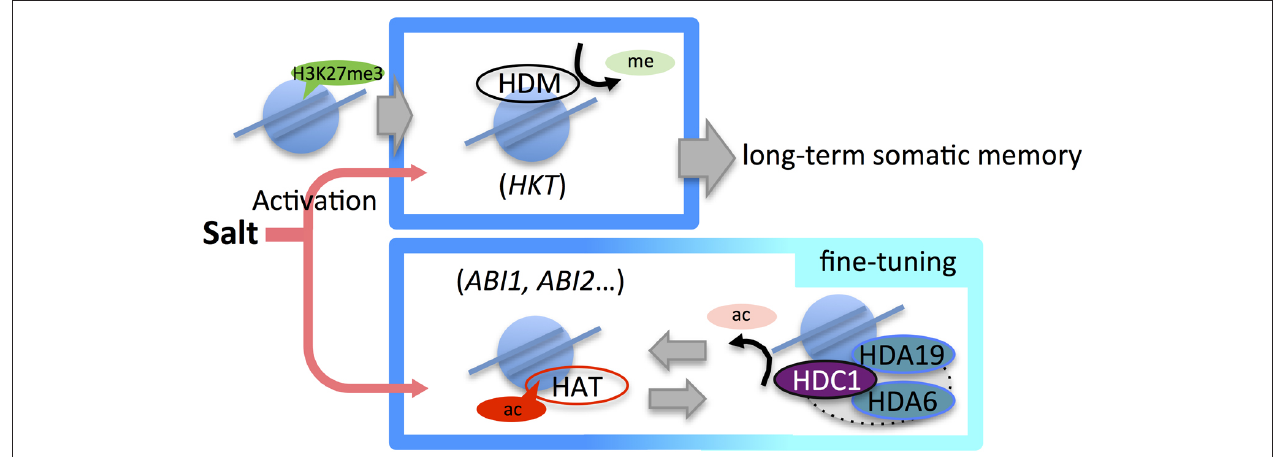
H3K27me3 levels in HKT established long-term memory for rapid response to a second stress (top). Under salt stress, the expression of genes such as ABI1 and ABI2 , which are associated with the abscisic acid (ABA) signaling pathway, is fine-tuned by epigenetic regulation mechanisms involving histone acetylation